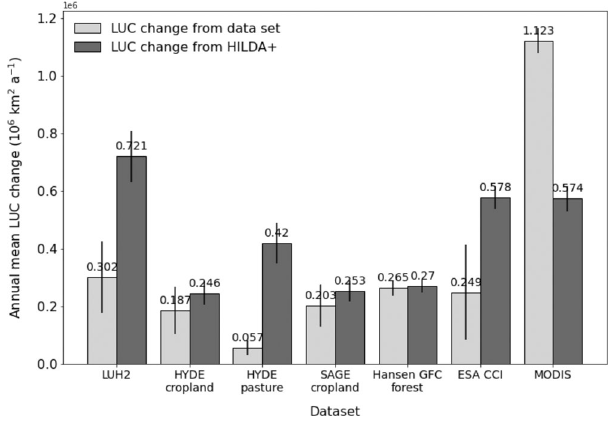
Fig. 5 Comparison of change rates. Comparison of mean annual gross land use/cover (LUC) change of different LUC change datasets (light grey bars) with HILDA + (dark grey bars). Error bars represent the standard